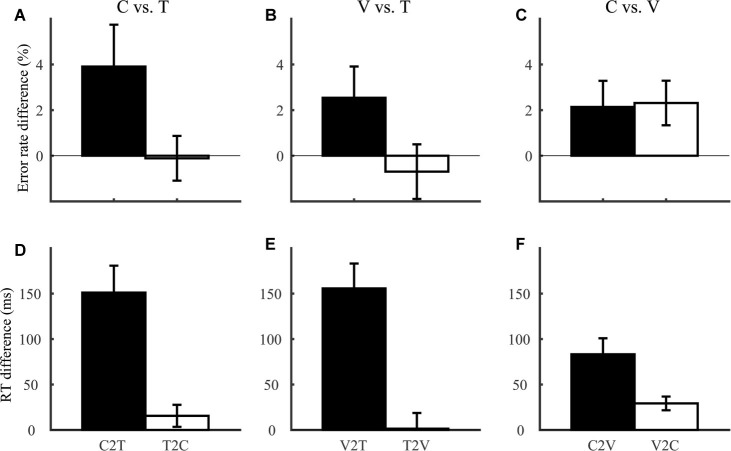
Interference between consonant (C), vowel (V), and tone (T) dimensions, indexed by error rate (A–C) and RT (D–F) differences. Each effect was labeled in the format of Y2X, indicating interference of the non-target dimension Y with judgments along the target dimension X. For example, C2T referred to interference of consonant variation with tone discrimination, calculated as error rate and RT differences between tone discrimination trials with different and same consonants.